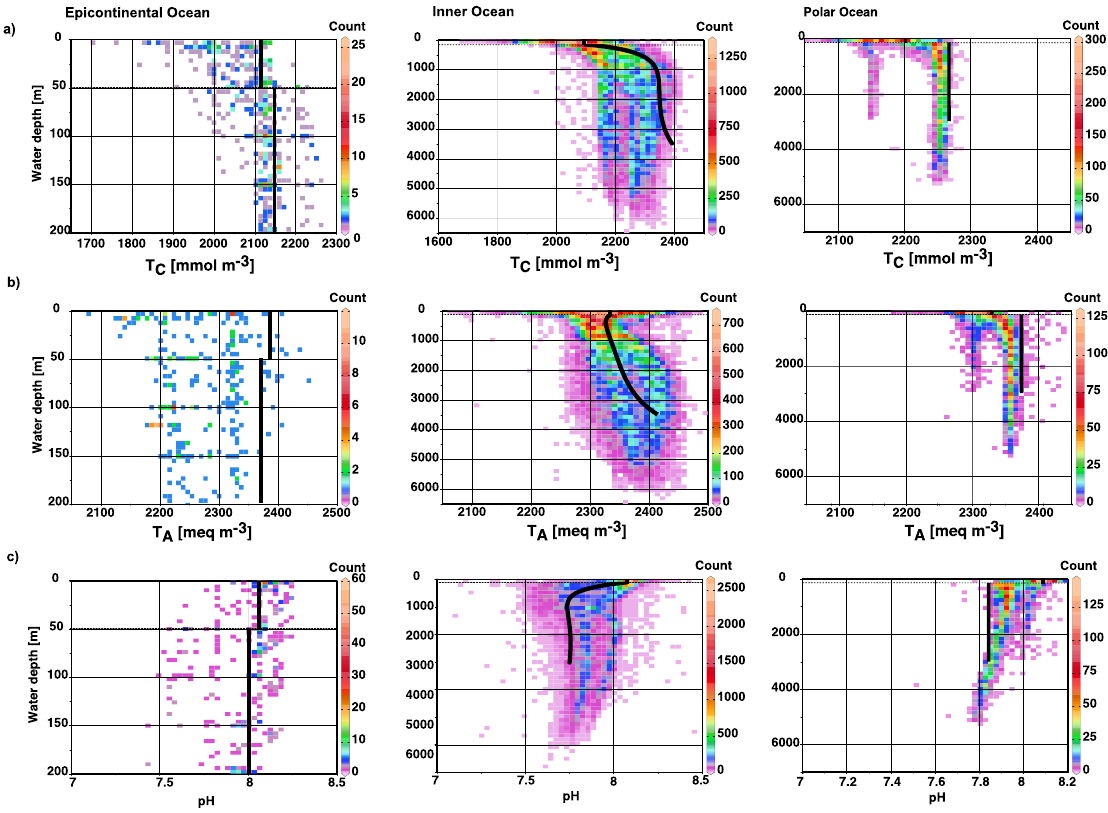
Fig. 7. Simulated steady state depth-profiles of (a) total dissolved inorganic carbon, (b) total alkalinity, and (c) pH in the epicontinental, inner and polar ocean (black line). Simulation results are compared to the dataset from the WOCE Hydrographic Program (*hy1.csv files from WHPO web-site as of 27 May 2002). The colour code indicates the number of times a concentration is reported for a given water depth.